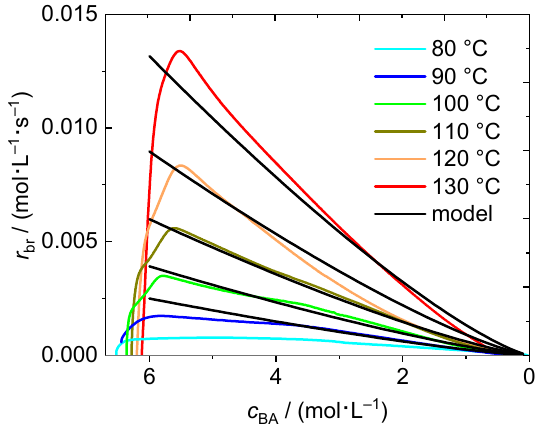
Figure 3. Rate of polymerization as a function of the actual BA concentration in the reaction mixture for the temperatures between 80 °C and 130 °C. Data resulting from the model calculation with Equation (4) is shown in black. The DSC data from temperatures between 90 and 130 °C is used to build a facile model for the description of the reaction rate in a self-initiated bulk polymerization of BA. r br is calculated according to Equation (4) with the overall rate coefficient, k eff,b , and the actual BA concentration, and the reaction order n. The reaction order is introduced since BA serves as initiator and monomer.